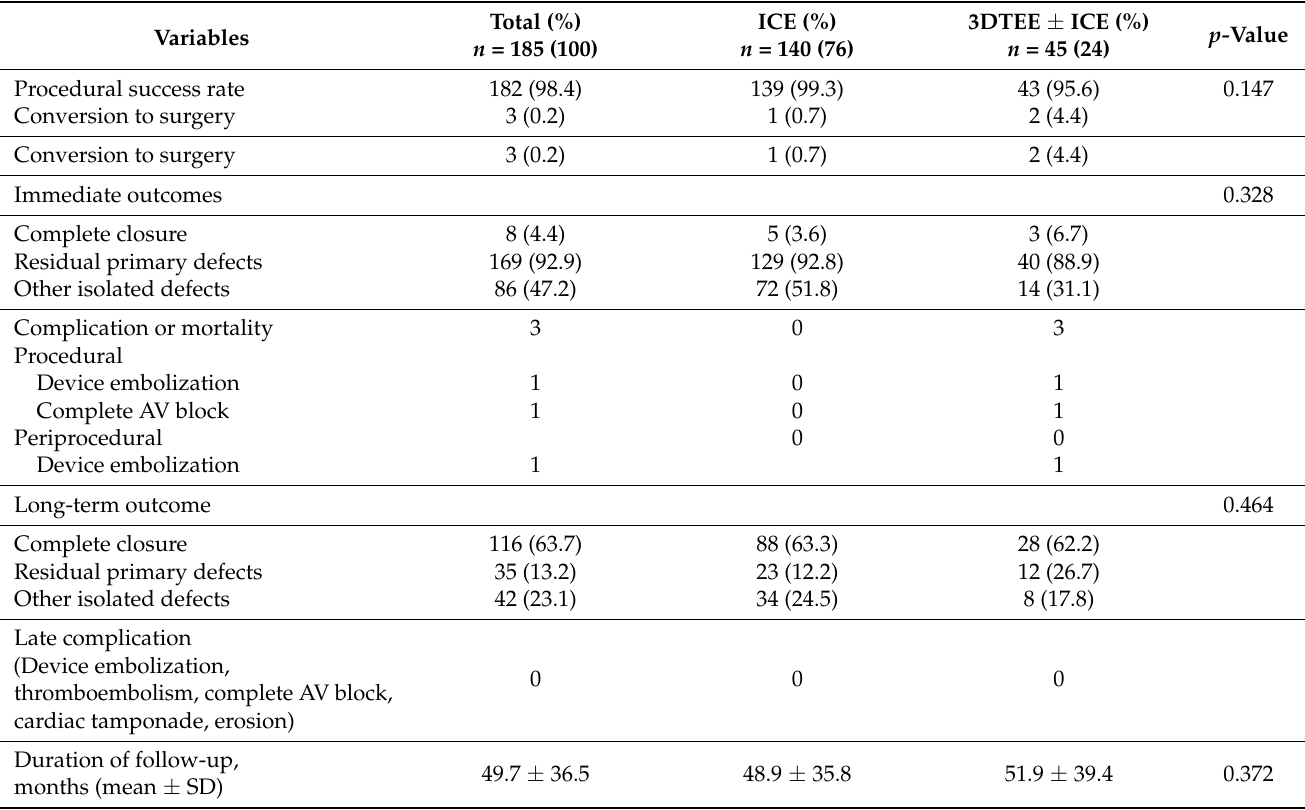
Table 3. Outcomes and